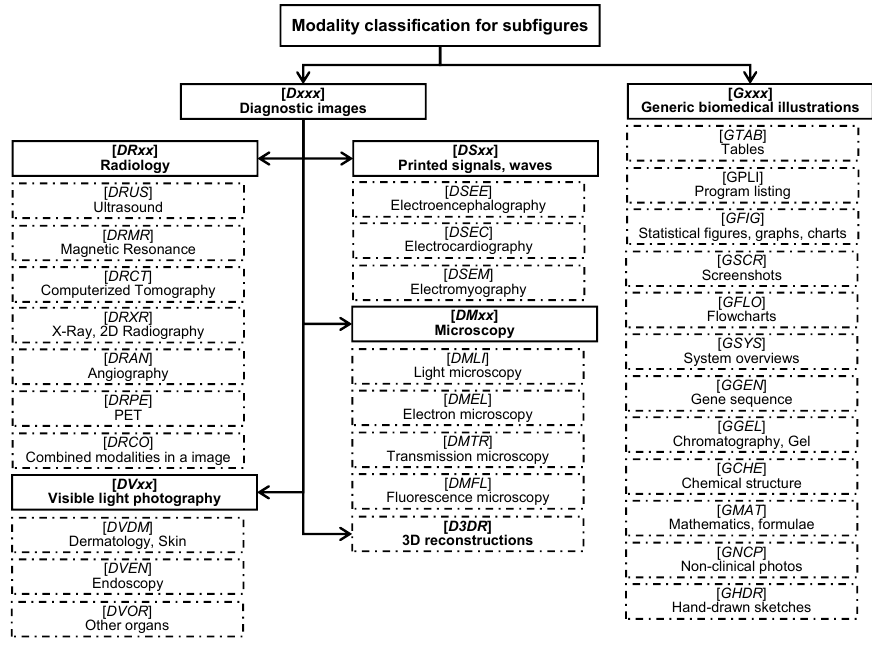
Figure 3. Thirty modality classes, along with the class codes in brackets.